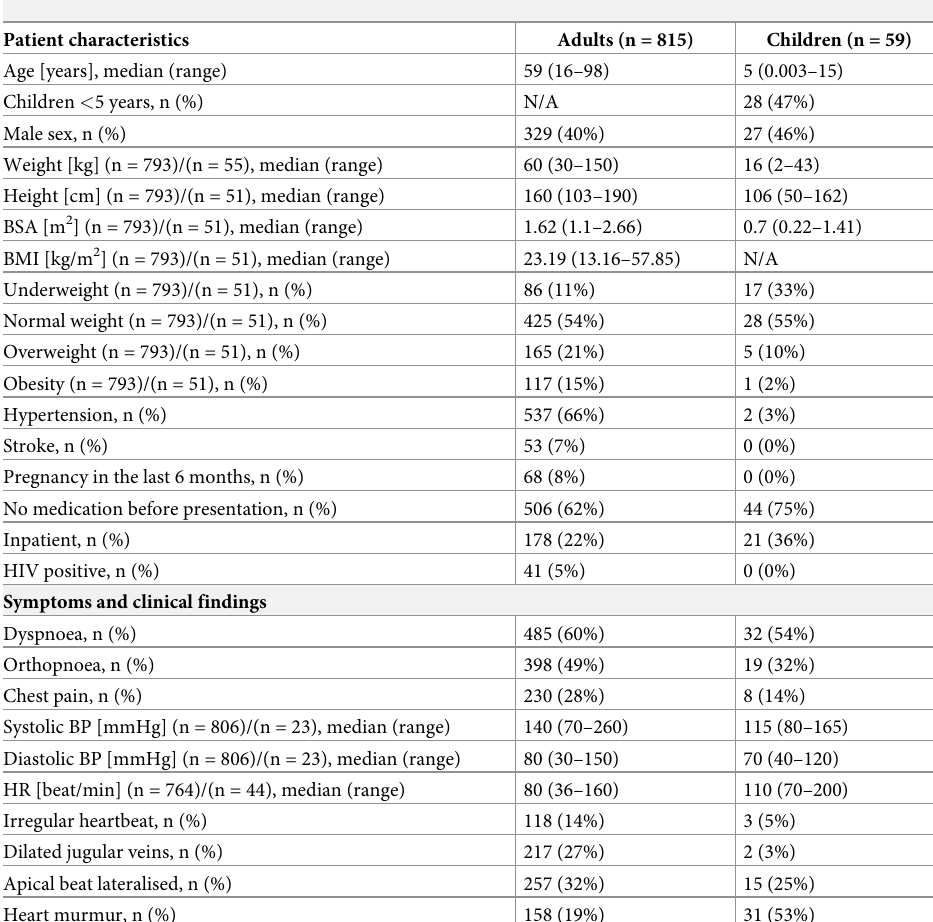
Table 1. Baseline characteristics. Patient